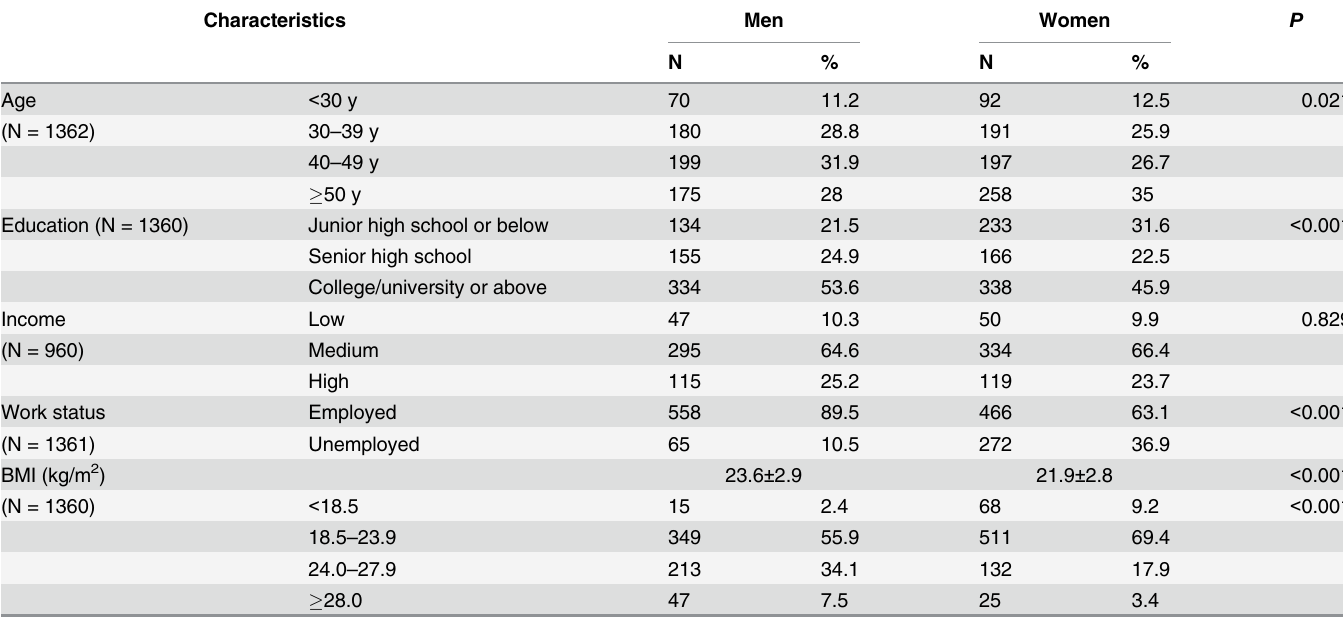
Table 1. Main characteristics of 1,362 participants.